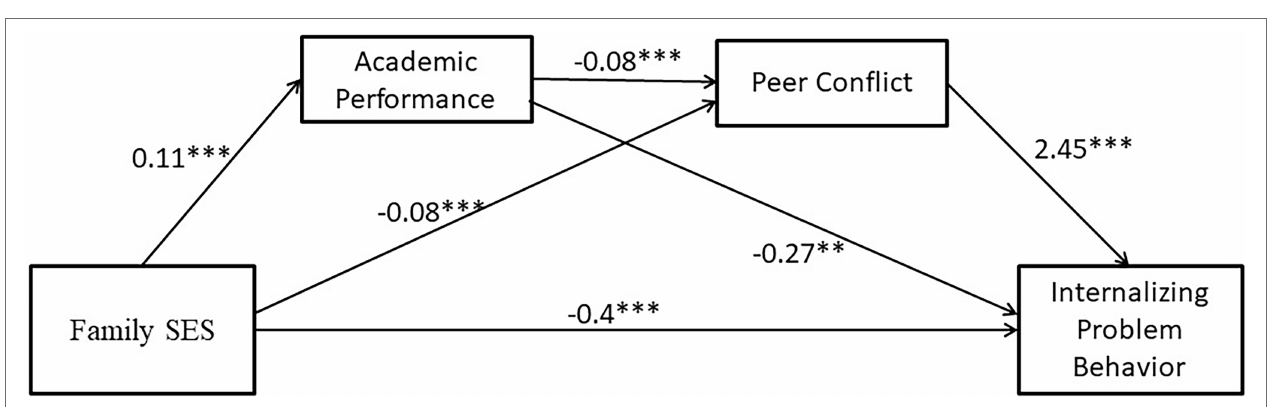
FIGURE 2 | The chain mediating effect of academic performance and peer conflict. ** p < 0.01 and *** p < 0.001.